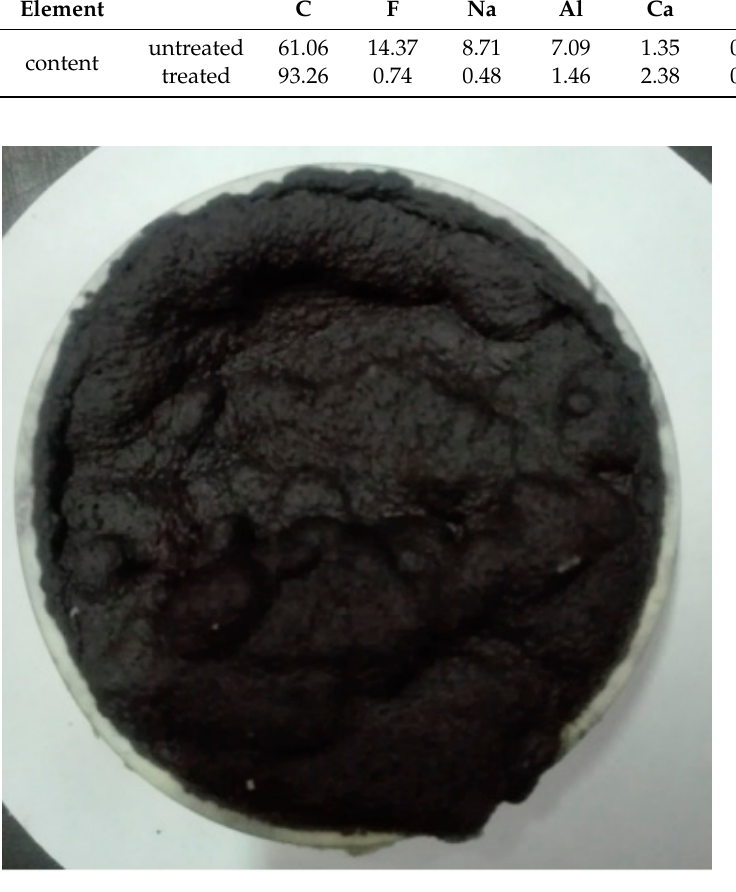
Figure 1. SCC after alkali fusion treatment.